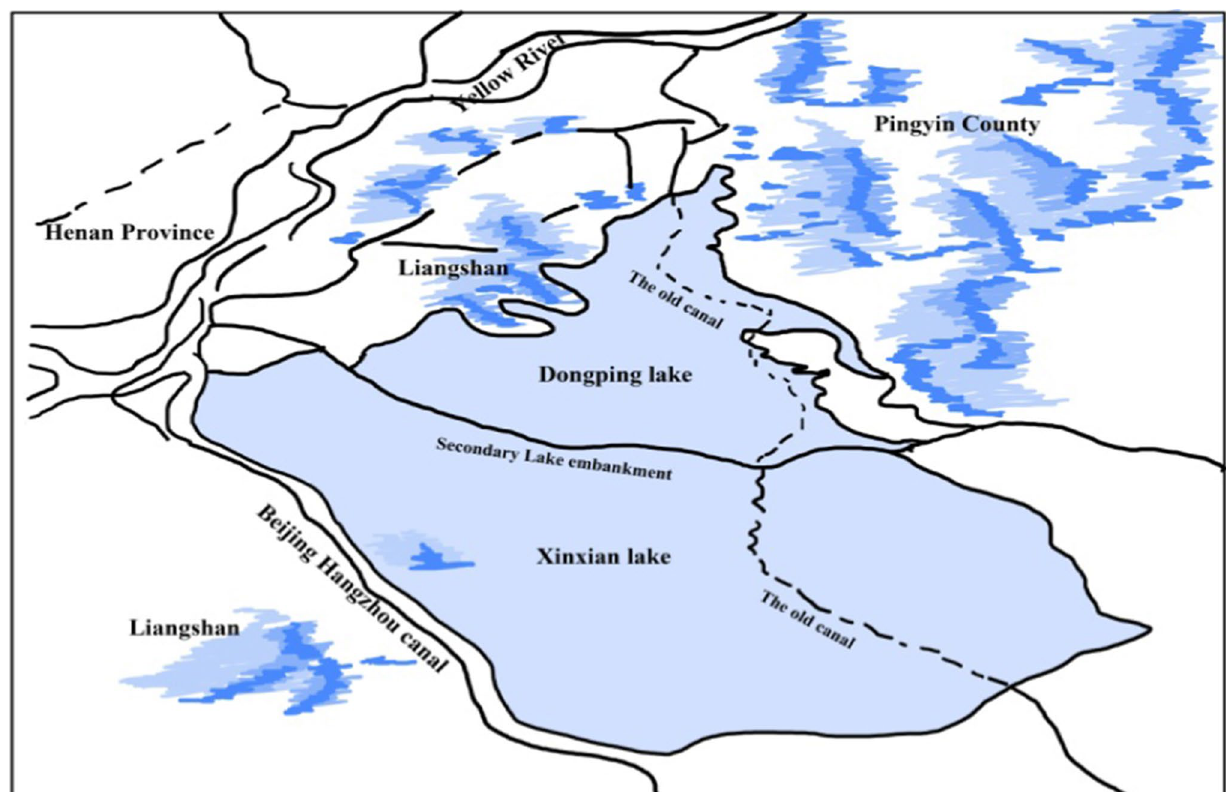
Fig. 1 Wetland location of the Dongping